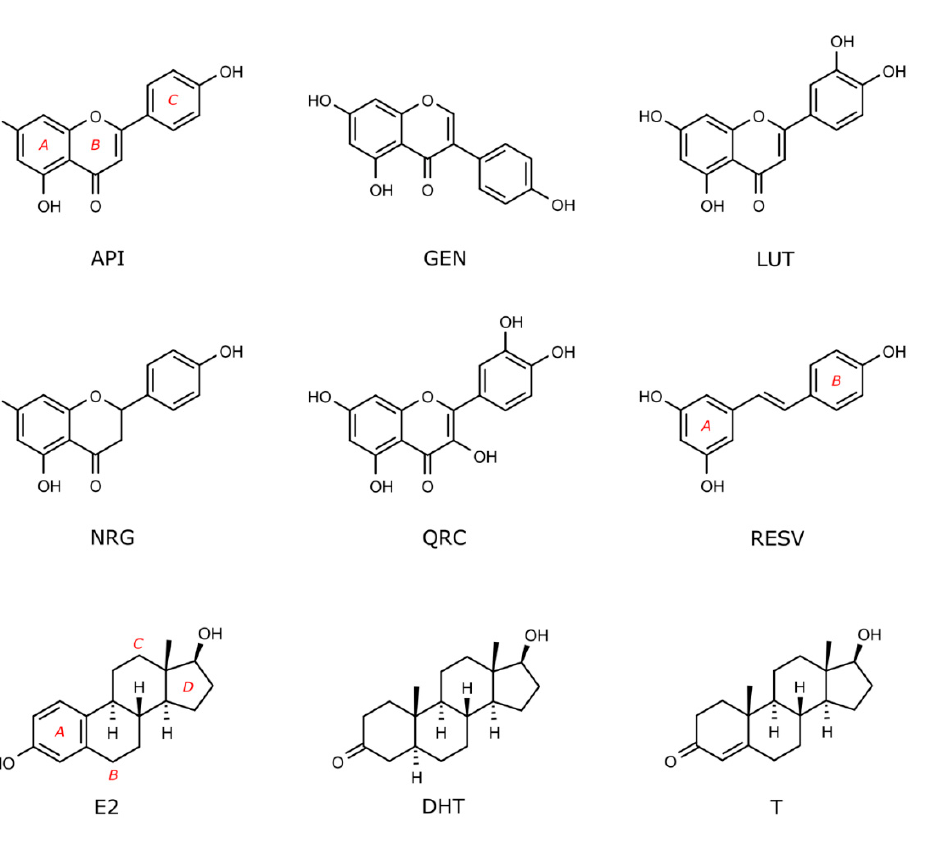
Figure 1. Flavonoids and sex steroid hormones docked in nuclear and membrane receptors shown in Figure 2. Compounds are indicated by their acronyms, as in the introduction and in the following legend: apigenin (API), genistein (GEN), luteolin (LUT), naringenin (NRG), quercetin, (QRC), resveratrol (RESV), 17 β -estradiol (E2), dihydrotestosterone (DHT), and testosterone